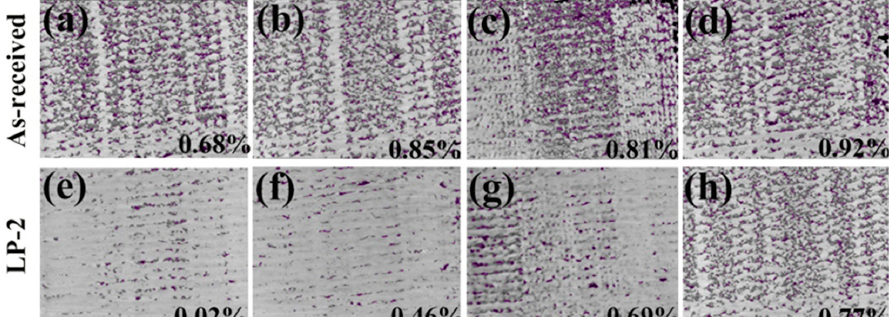
Figure 6. The pore distribution of the as-received sample at different distances: ( a ) 0–10 µm; ( b ) 30–40 µm; ( c ) 60–70 µm, and ( d ) 70–100 µm. The pore distribution of the LP-2 sample at different distances: ( e ) 0–10 µm; ( f ) 30–40 µm; ( g ) 60–70 µm; and ( h ) 70–100 µm. (The purple part of the image,